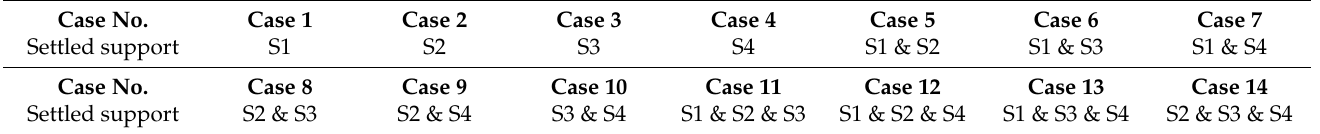
Table 3. Cases of support settlements.